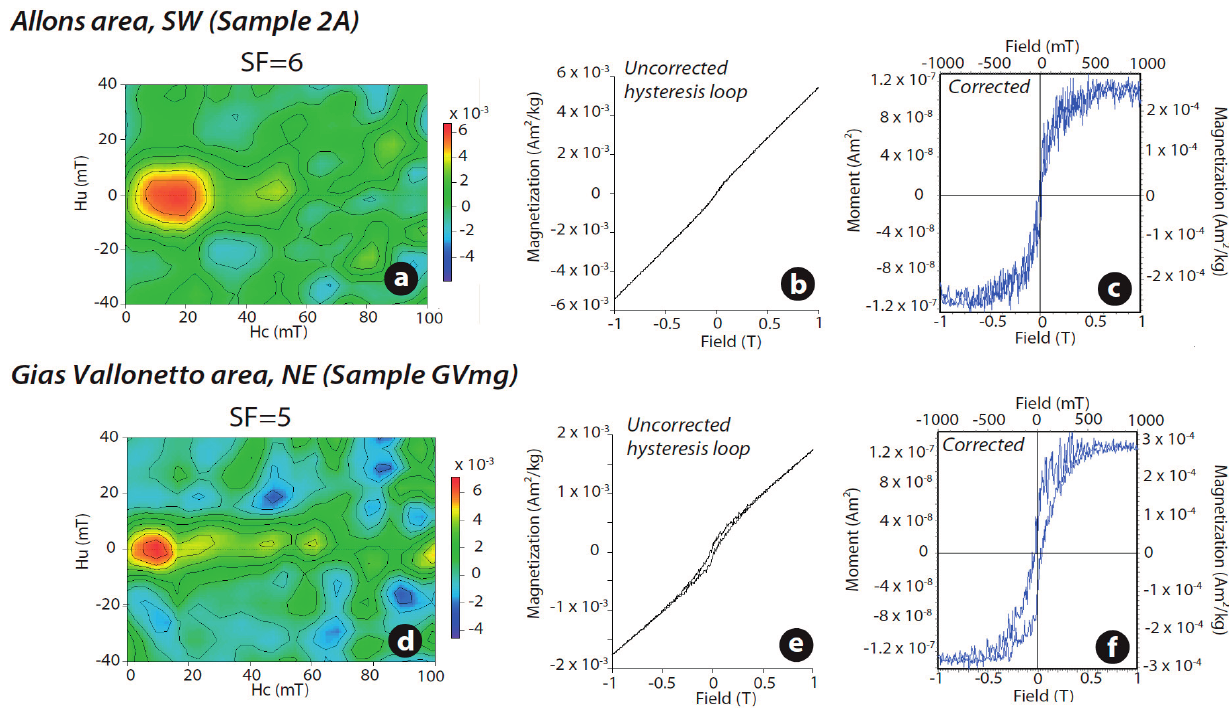
Figure 4. First-order reversal curves (FORC) diagrams ( a , d ) and hysteresis loops, both uncorrected ( b , e ) and corrected ( c , f ), run at room temperature for two samples. SF is the smoothing factor. Note that the corrected hysteresis loops are noisy (weak signal), as a result of the low concentration of ferromagnetic